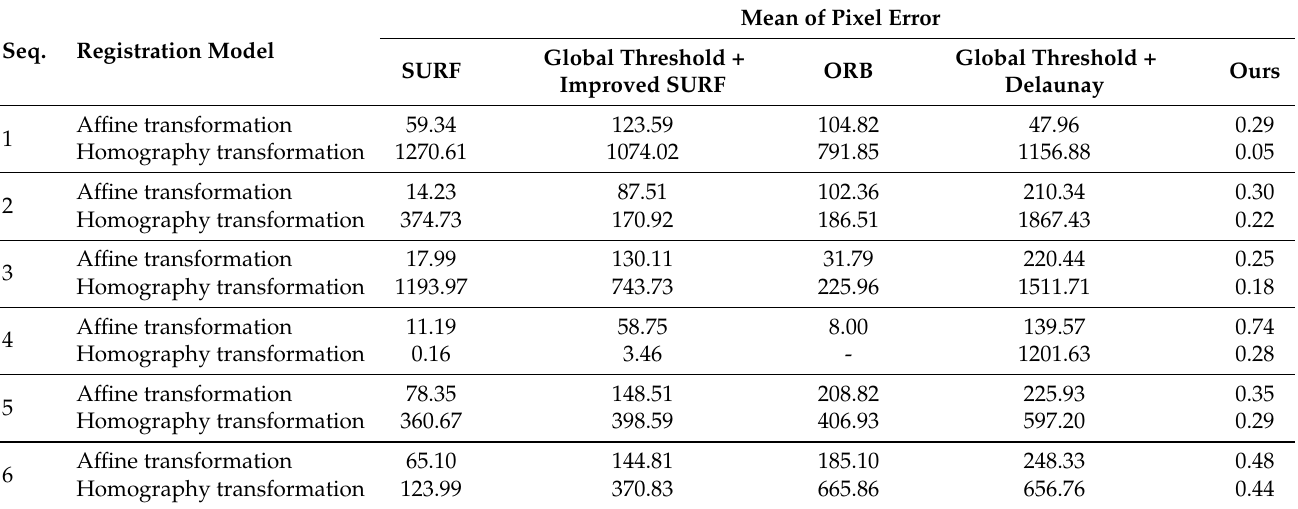
Table 6. Comparison of pixel error among the proposed method and